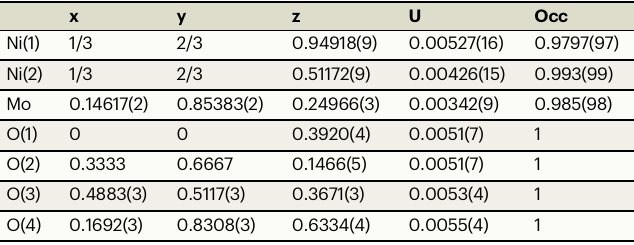
Table 1 | Positions of atoms in Ni 2 Mo 3 O 8 as determined from single crystal X-ray